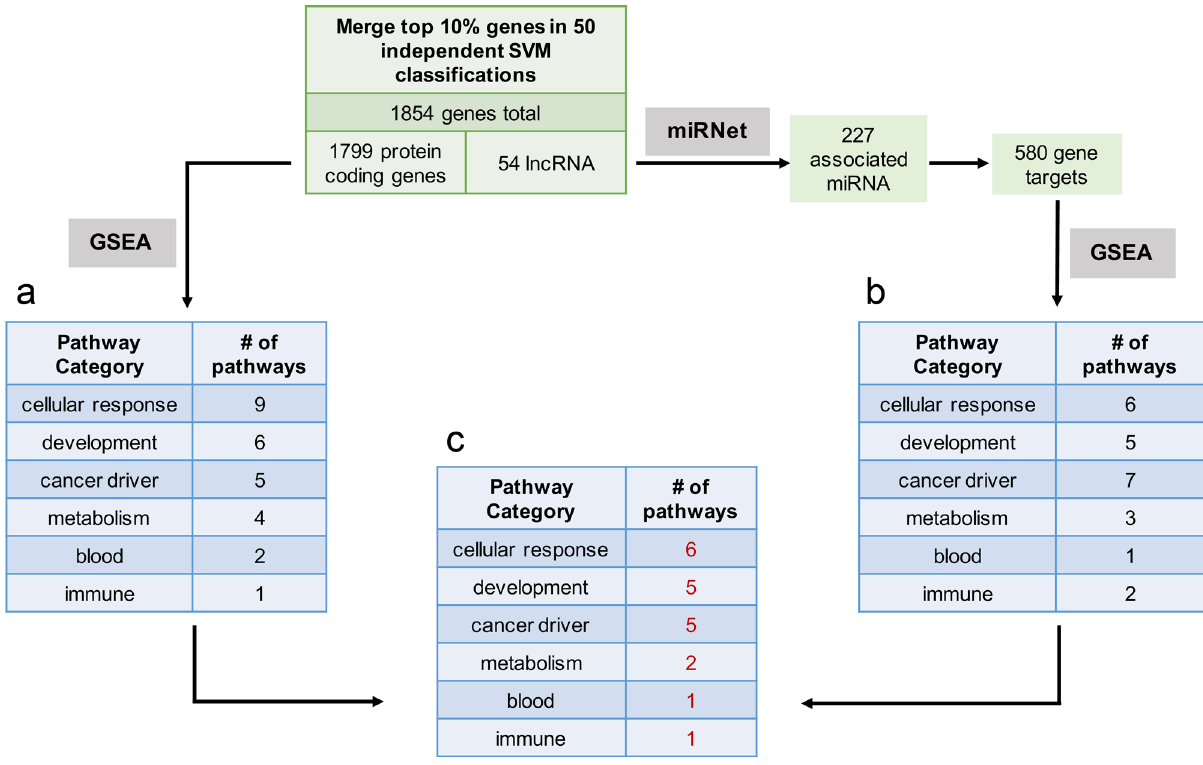
Fig. 1 Work fl ow for support vector machine (SVM) classi fi cation of samples from TCGA and CCLE to assign feature importance to all genes. a GSEA pathway enrichment results of 1799 protein-coding genes in the overlap of the top 10% most important genes in 50 independent SVM classi fi cations. b GSEA pathway enrichment results of 580 protein-coding genes linked by miRNet databases to the 54 lncRNAs found in the overlap of the top 10% most important genes in 50 independent SVM classi fi cations. c Overlap of pathways from the protein-coding gene GSEA and the lncRNA-based